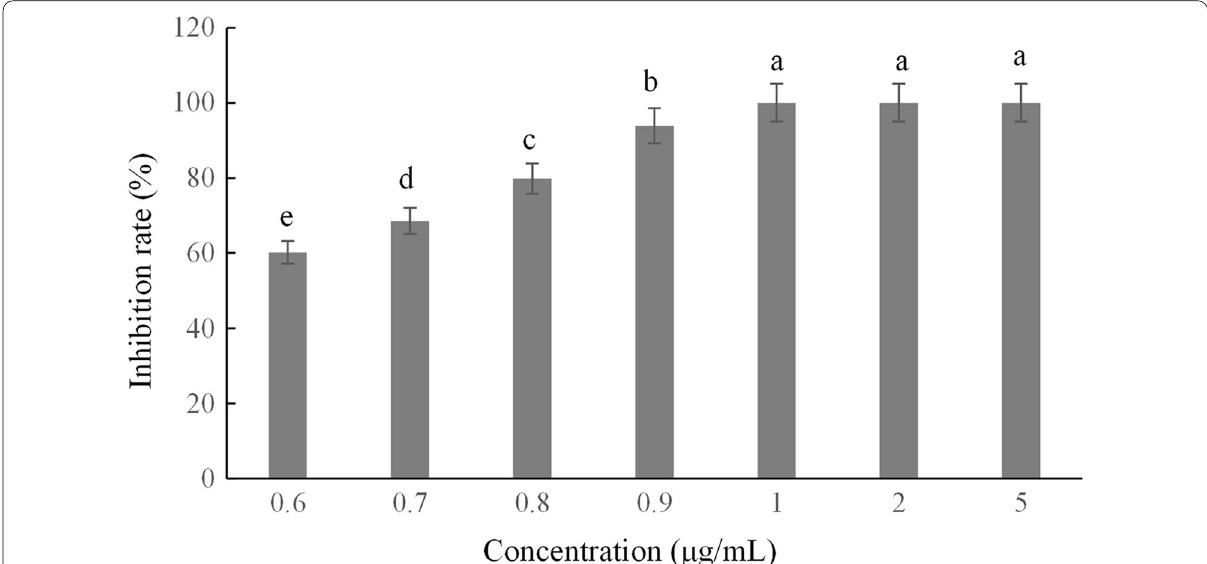
Fig. 3 The germination rate and inhibition rate of O. aegyptiaca seeds treated by different concentration of crude extract from B. velezensis. The different small letters represent significance at 5% level